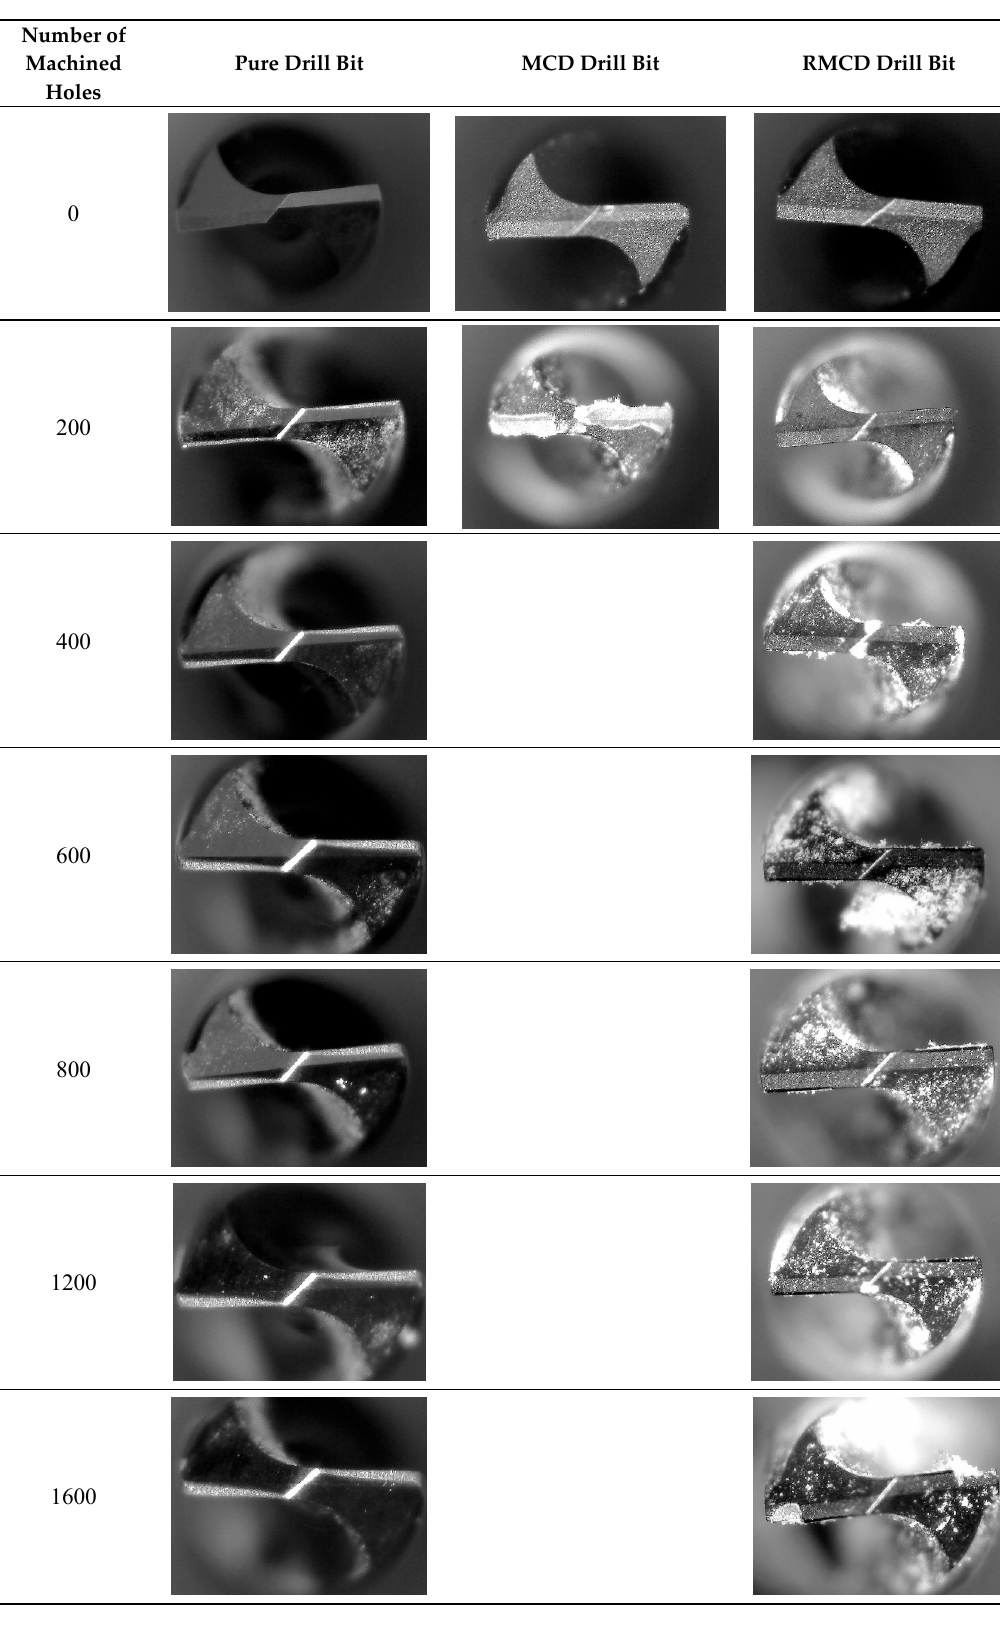
Figure 3. Shapes of the pure, MCD, and RMCD drill bits after machining the printed circuit board (PCB)